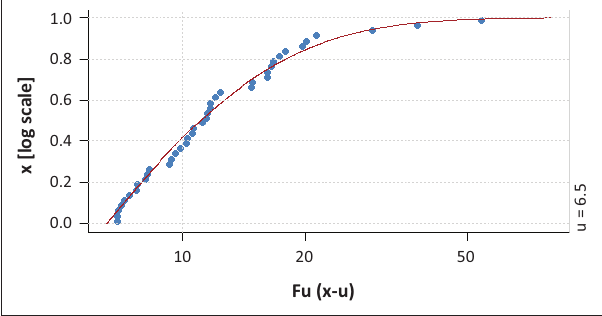
FIGURE 19: Kenya – Diagnostic plot for peak over threshold analysis: Excess distribution.